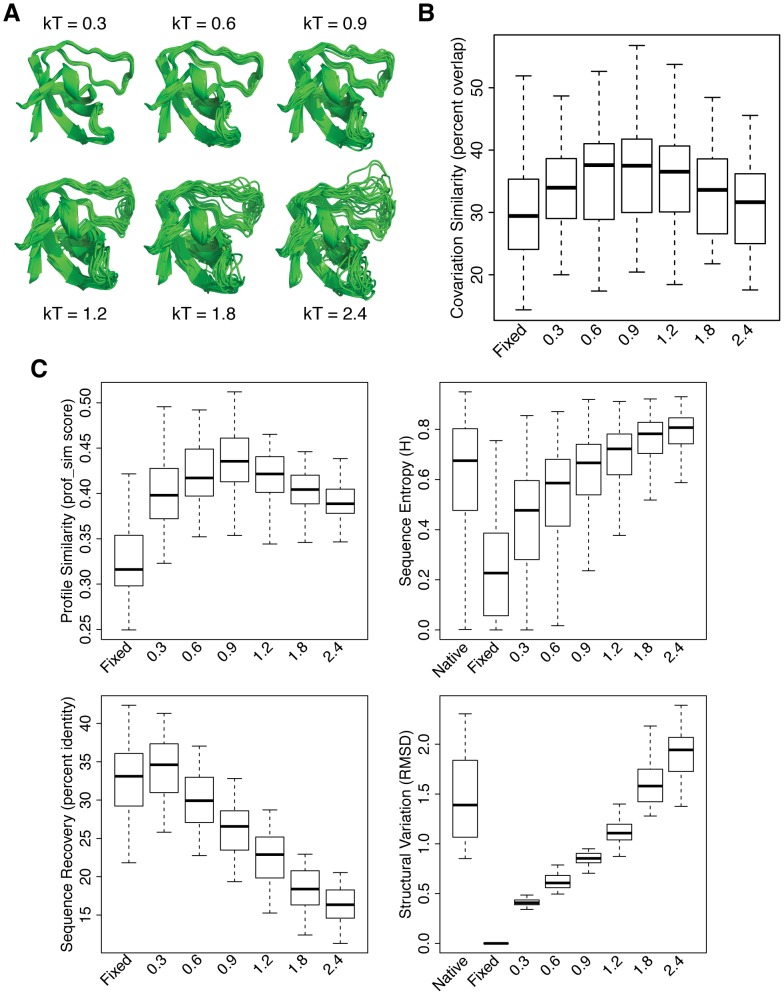
Effects of the magnitude of structural variation on sequence properties.A) Representative structures of conformational ensembles generated using backrub Monte Carlo simulations with different temperature parameters (shown for an SH3 domain). B) Box plot showing the distributions of covariation similarity values between natural sequences and sequences designed using conformational ensembles generated with different temperature parameters (including “Fixed” backbone design sequences). Each distribution contains 40 covariation similarity values, one for each of the 40 protein domains. For each box plot in this study, the top and bottom whiskers denote the maximum and minimum values, respectively. The top and bottom of the box indicates the 75th and 25th percentiles, respectively, and the bold line denotes the 50th percentile. C) Box plots showing the distributions of sequence and structural characteristics for each temperature. The sequence profile similarity, sequence recovery and structural variation distributions each contain 40 values, one for each of the 40 protein domains. The sequence entropy distributions each contain 2778 values, one for each position in the 40 protein domains. “Native” distributions for structural variation and sequence entropy of the natural proteins were included as well.